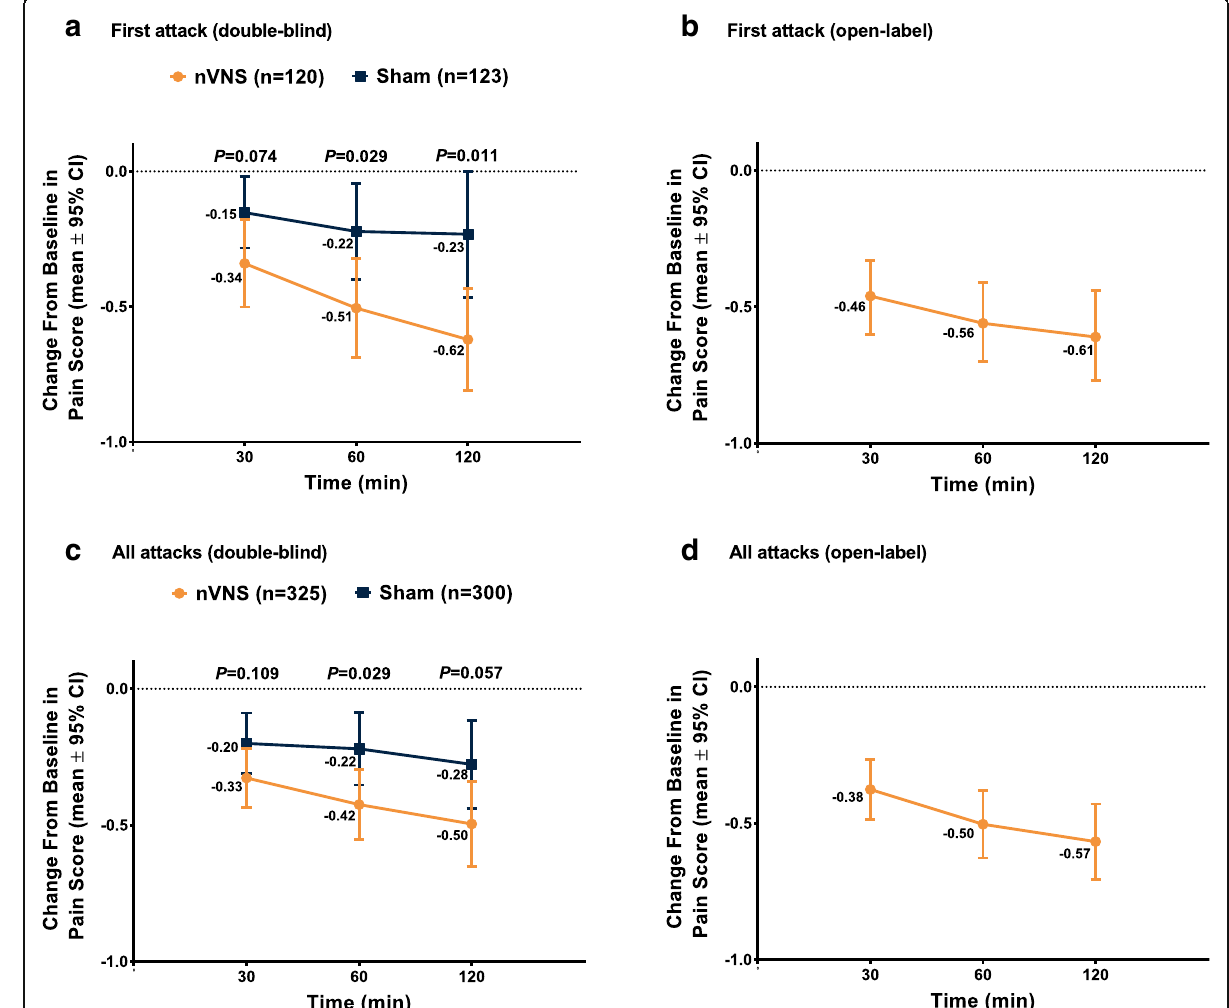
Fig. 3 Mean change in pain score from baseline for first attack during the double-blind ( a ) and open-label ( b ) periods and for all attacks during the double-blind ( c ) and open-label Periods ( d ). P values for first attack are from 2-sample t tests. For all attacks, linear mixed effects regression models were used to estimate the change in pain score between baseline and 30, 60, and 120 min, allowing for both subject-specific and population- averaged inferences. Abbreviations: CI, confidence interval; nVNS, non-invasive vagus nerve